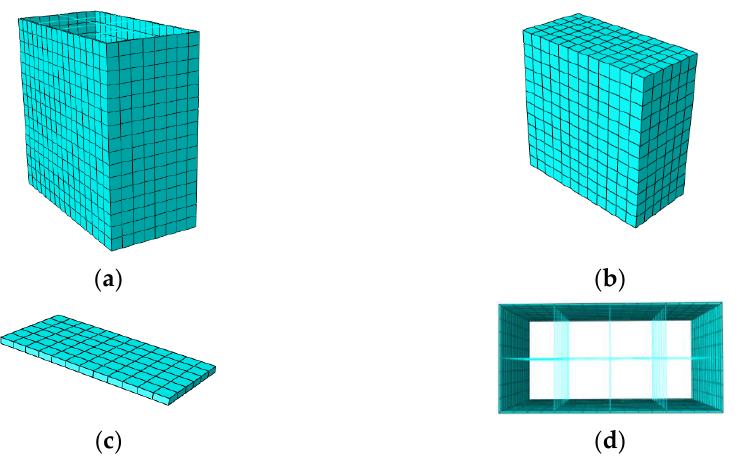
Figure 3. Mesh generation of FEM models: ( a ) 1/2 Steel tube element; ( b ) concrete element; ( c ) loading plate element; ( d ) steel tube-stirrups element.